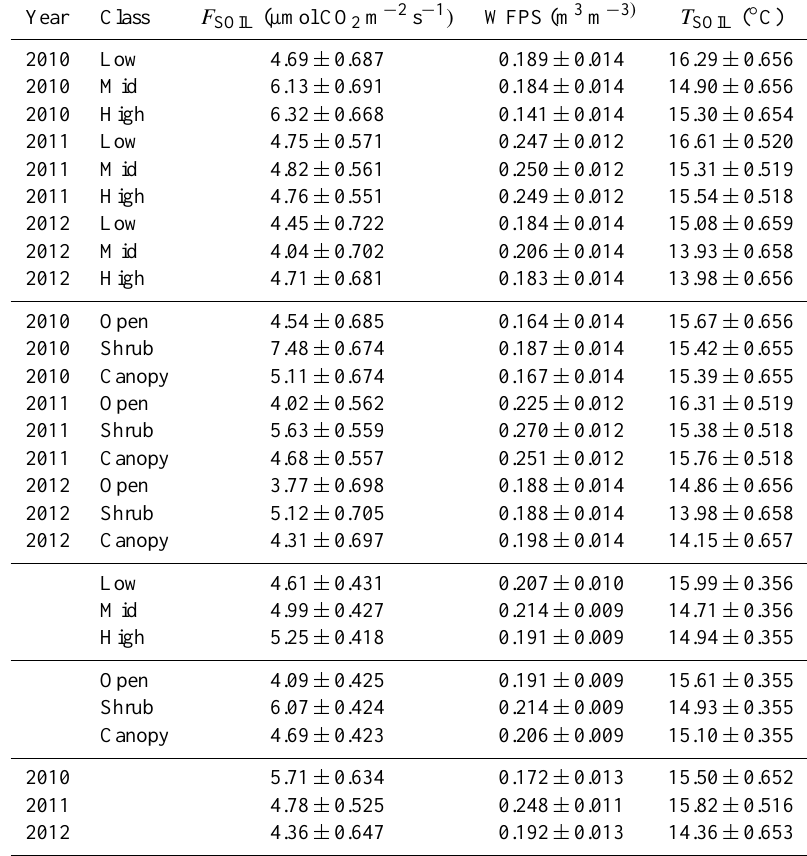
Table 1. Least-squares means of dynamic environmental variables. Error terms indicate standard